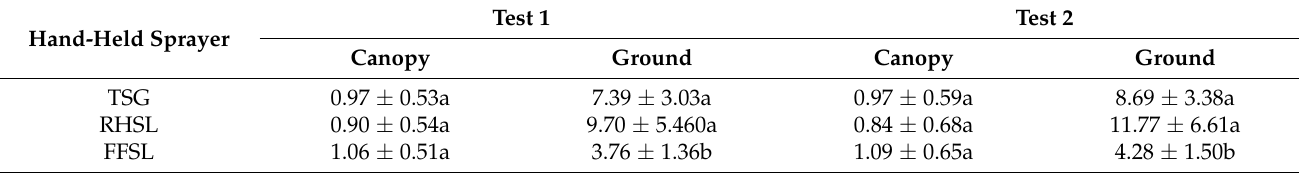
Table 3. Normalised deposition on the canopy and losses to the ground (mean ± SD) in µ L cm − 2 . Hand-Held